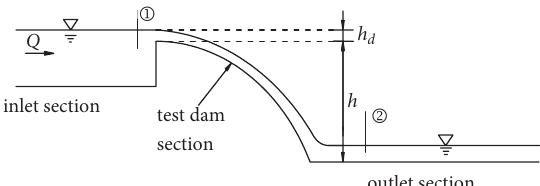
Fig. 1. Schematic diagram of the experimental